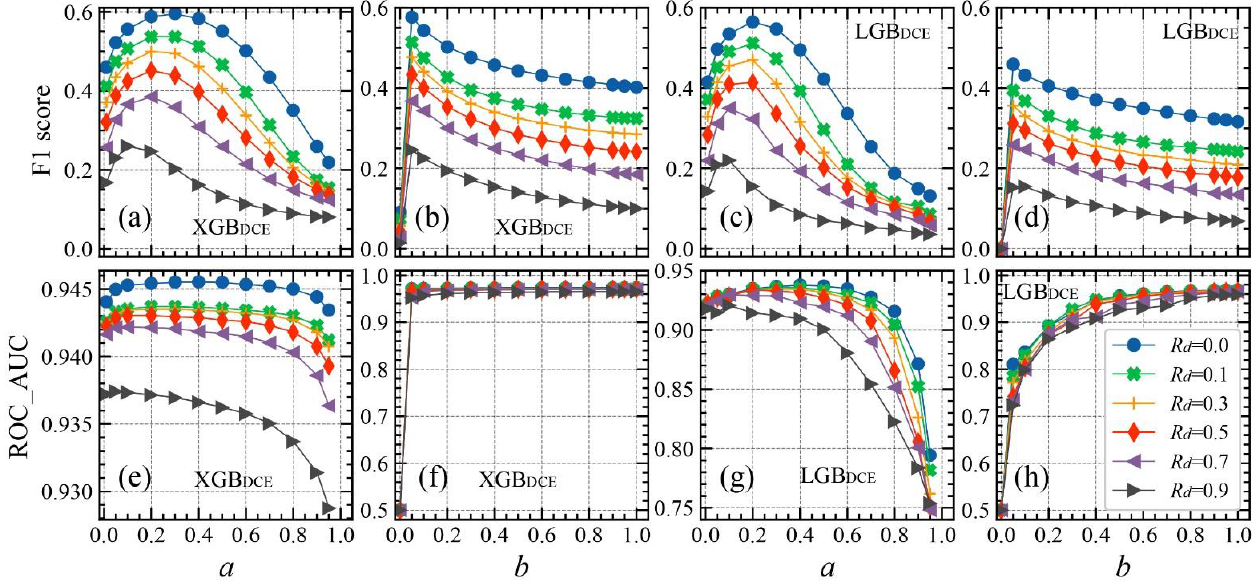
Figure 5. The influence that parameters a and b in the DCE loss function exert on landslide suscep- tibility prediction using the ( a , b , e , f ) XGB DCE and ( c , d , g , h ) LGB DCE models. As R d increases, the part of the landslide that the model seeks to predict is reduced from the entire landslide to the landslide scarp.